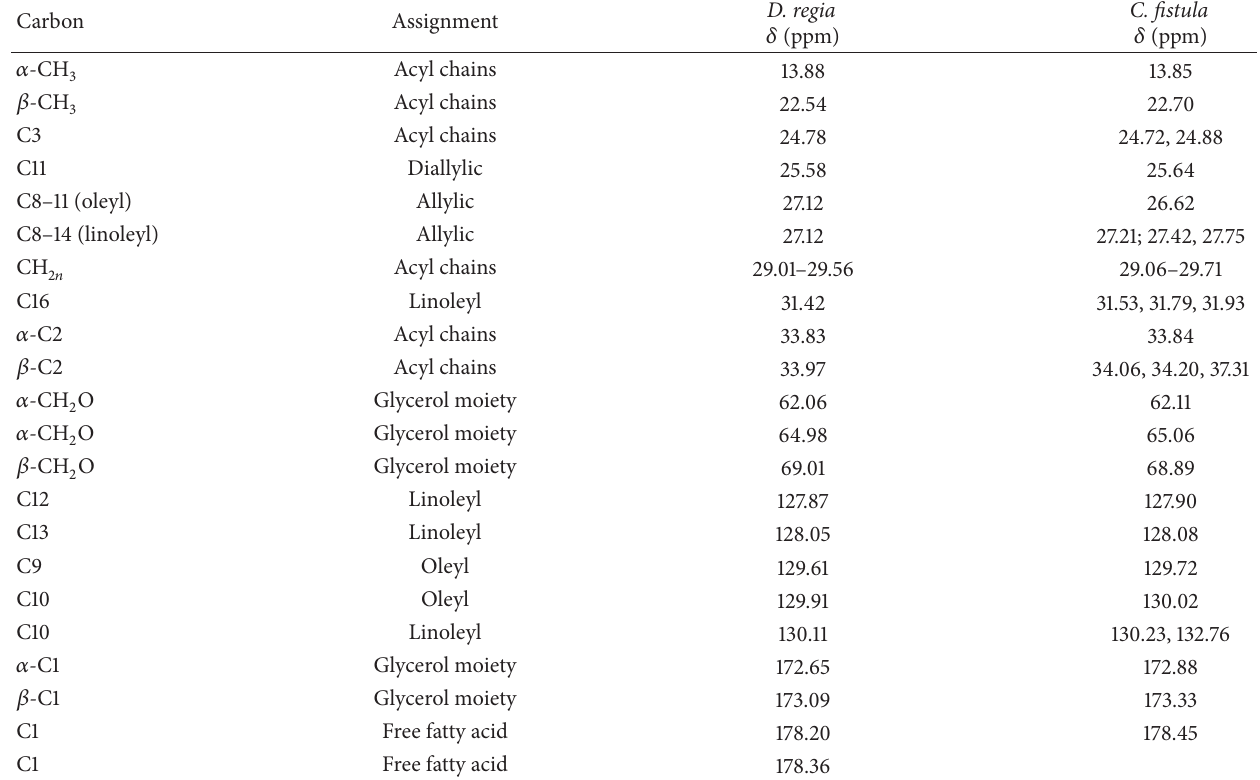
Table 5: 13 C Nuclear magnetic resonance spectroscopy data of seed lipid